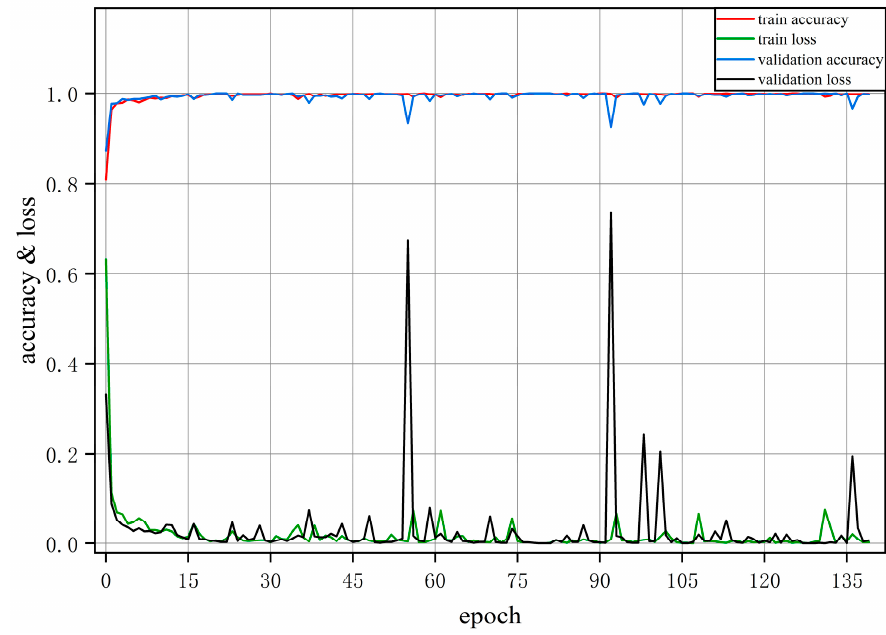
Figure 4. Prediction accuracy and prediction loss in training and validation set in 140